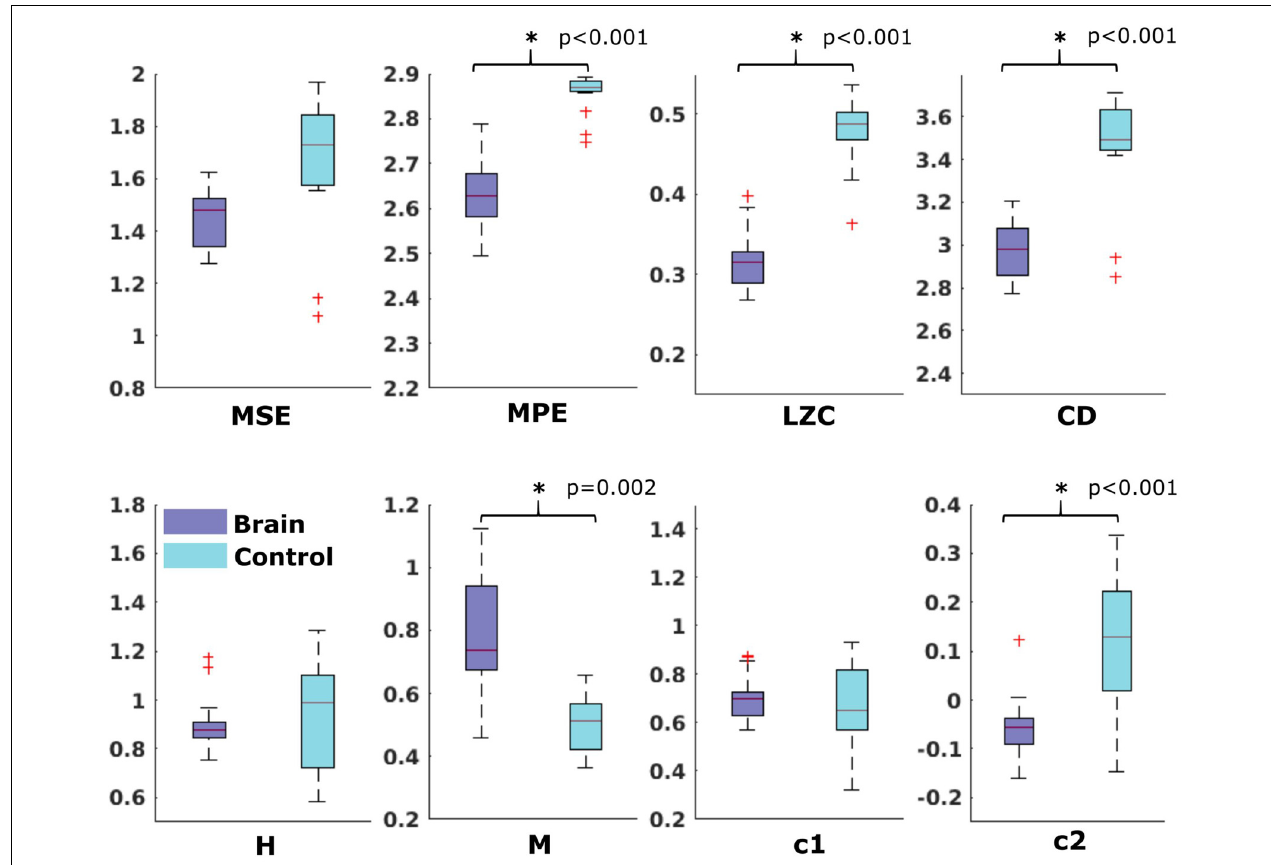
FIGURE 7 | Results from analysis of different metrics on data from neonates without stimulation. ∗ Depicts significant difference ( p = 0.006).